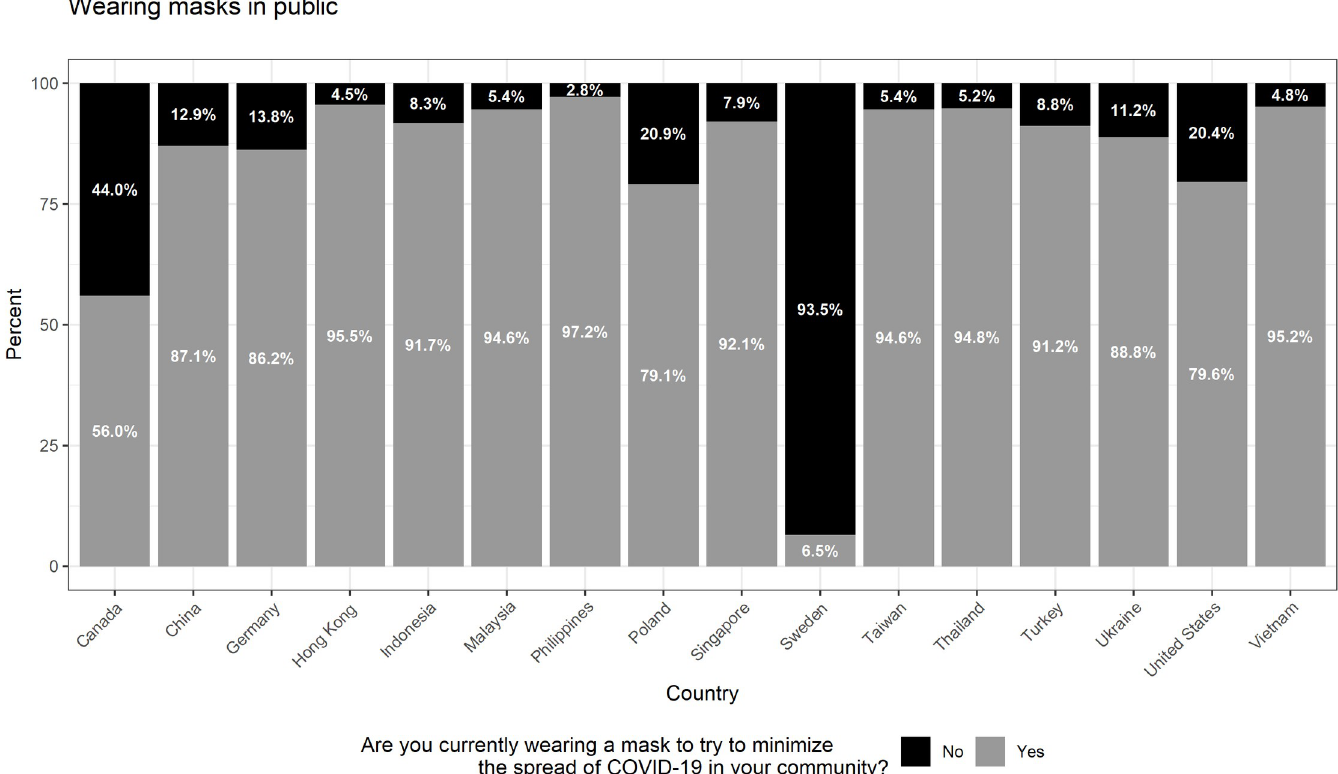
Fig 1. Self-reported mask wearing by country/territory. This figure summarizes individual responses (yes, no), by country/territory, regarding whether they have been wearing a face mask to try to minimize the spread of the COVID-19 in their community. Sample size by country/territory: Canada = 1077; China = 1177; Germany = 1056; Hong Kong = 582; Indonesia = 1097; Malaysia = 959; Philippines = 1160; Poland = 1107; Singapore = 541; Sweden = 1058; Taiwan = 759; Thailand = 1105; Turkey = 1108; Ukraine = 1101; United States = 1228; Vietnam = 1048.